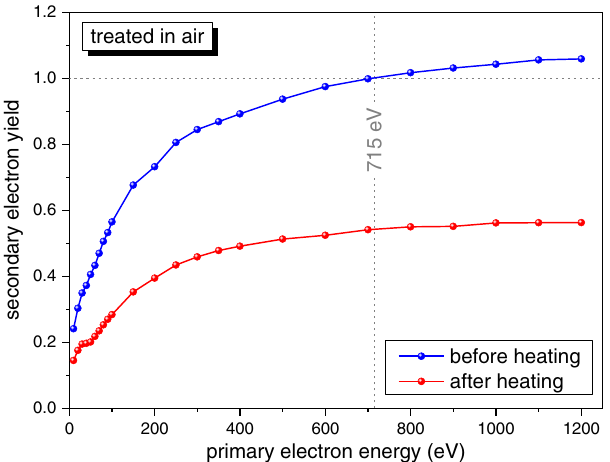
FIG. 3. Room-temperature SEY curves measured on the CH- patterned air-treated sample before (blue line) and after (red line) thermal treatment at 300 °C in a vacuum (no air exposure after heat treatment). The energy for which the SEY increases above unity is indicated.